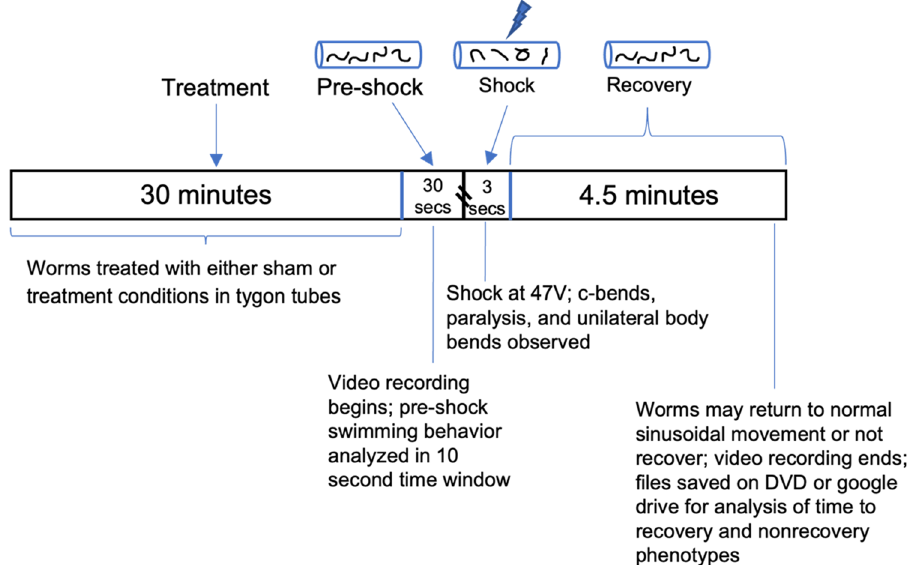
Figure 4. A detailed schematic of the timeline of electroshock assay data collection. Above the timeline are the four critical time parts of the assay. Below the timeline are details of each part and the crucial phenotypes that are